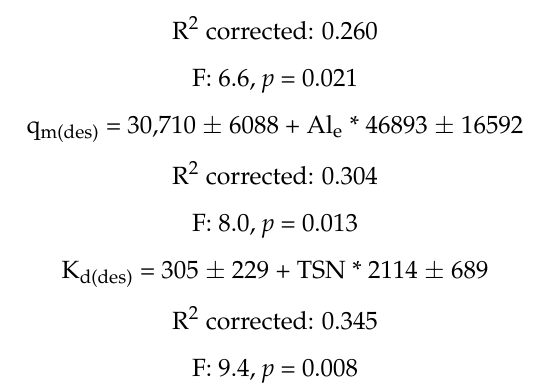
(Table 8): K L(des) correlated negatively with the sand fraction (r = − 0.501, p < 0.05) and positively with the silt fraction (r = 0.553, p < 0.05); q m(des) correlated positively with Al e (r = 0.589, p < 0.05) and negatively with the silt fraction (r = − 0.494, p < 0.05); finally, K d(des) was positively correlated with SOC (r = 0.499, p < 0.05) and TSN (r = 0.621, p < 0.01). For CIP desorption, the following significant equations were